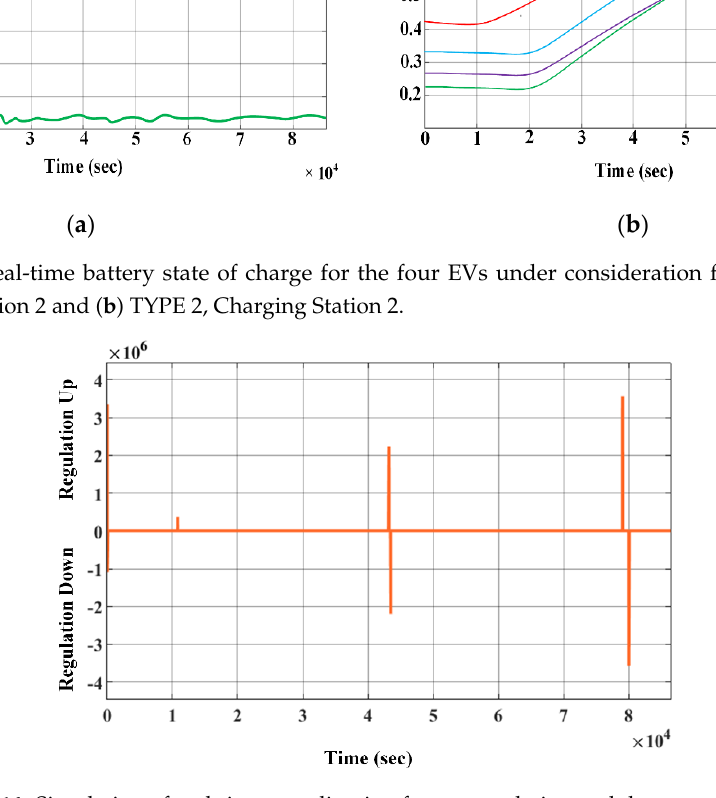
Figure 14. Simulation of real-time coordination for up-regulation and down-regulation.